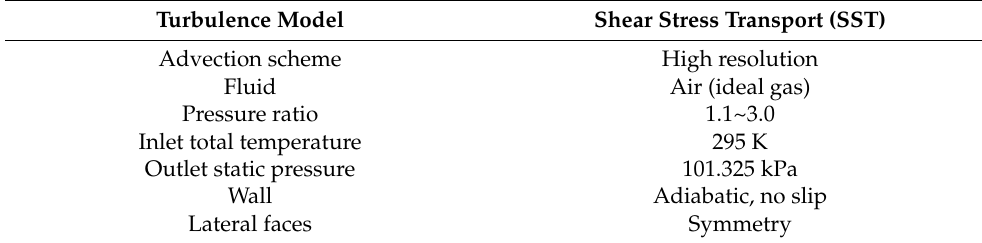
Table 2. Numerical methods and boundary conditions.